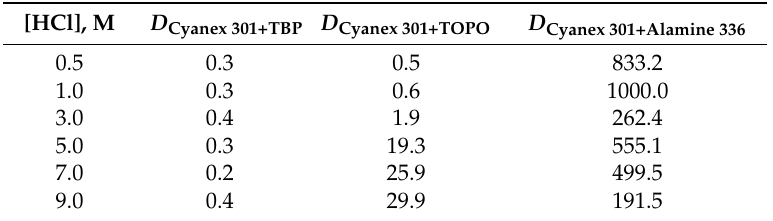
Table 3. Distribution ratio of Pd(II) with Cyanex 301 + TBP, Cyanex 301 + TOPO, and Cyanex 301 + Alamine 336.